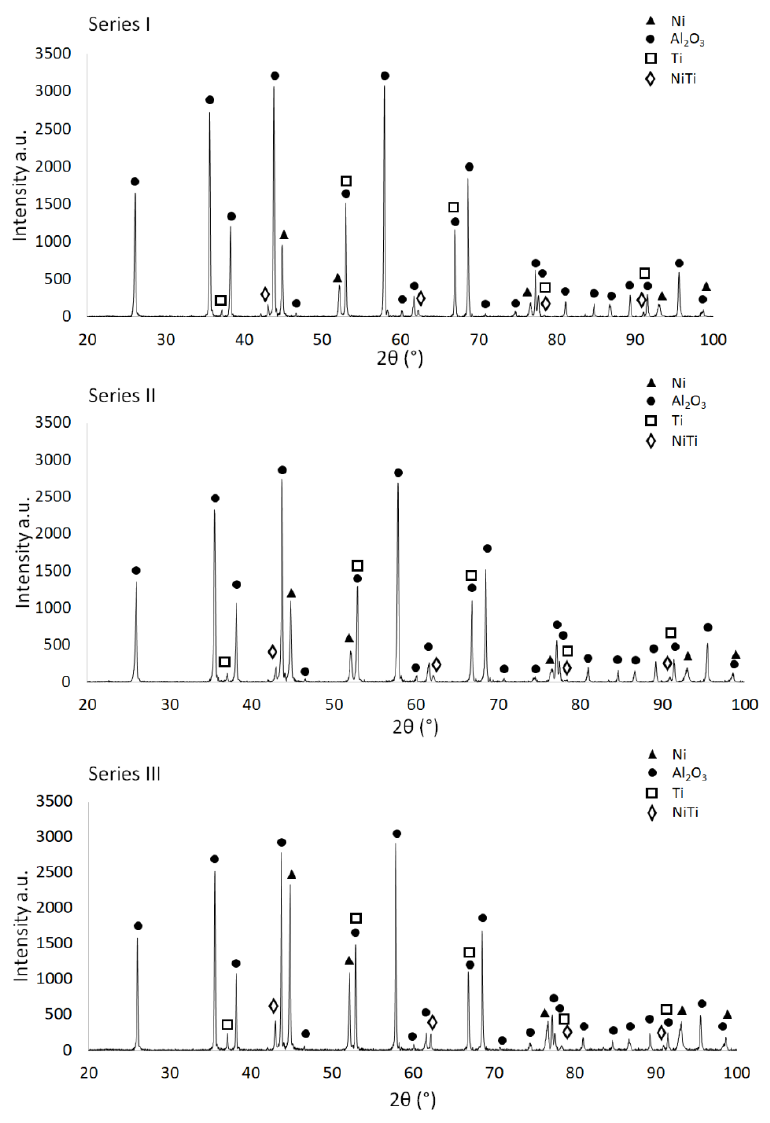
Figure 8. Diffractograms for samples after the sintering process. 400 The formation of new phases as a result of the sintering of samples from the 401 Al 2 O 3 /Ti/Ni system is confirmed by the available literature on the subject, which clearly 402 indicates the potential of intermetallic formation in composites containing both Ti and Ni 403